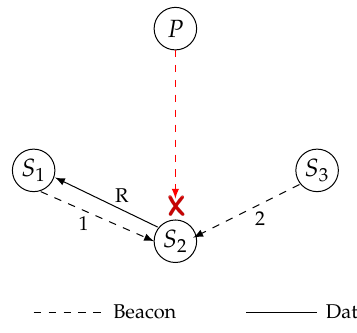
Figure 6. Relay selection among sibling.